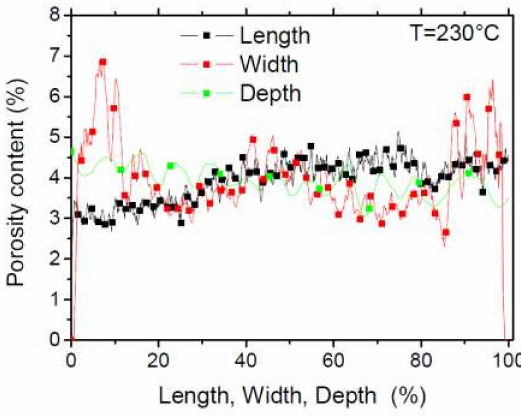
Figure 10. Porosity content in the three main directions in printed wood-PLA / PHA.